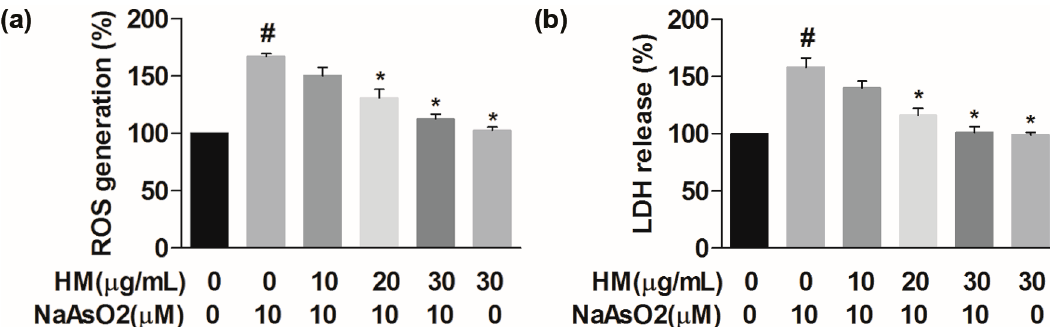
Figure 2. HM inhibited the reactive oxygen species (ROS) and lactate dehydrogenase (LDH) release in HepG2 cells. ( a ) Intracellular ROS and ( b ) LDH levels were measured. Cells were pretreated with different concentrations of HM (10, 20, and 30 μ g/mL) for 1 h, followed by co-treatment with 10 μ M NaAsO 2 for another 24 h. Data are expressed as mean ± standard error mean (SEM) of three independent experiments. # p < 0.05 compared with the control and NaAsO 2 group, and * p < 0.05 compared with the NaAsO 2 and HM extract-treated groups.